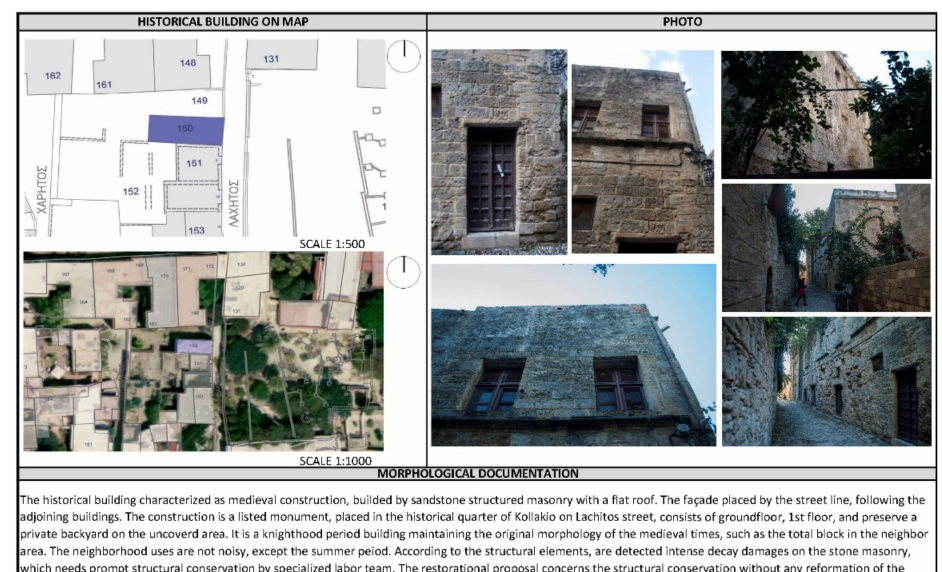
Figure 12. Example of an evaluation sheet of selected buildings: second page—description